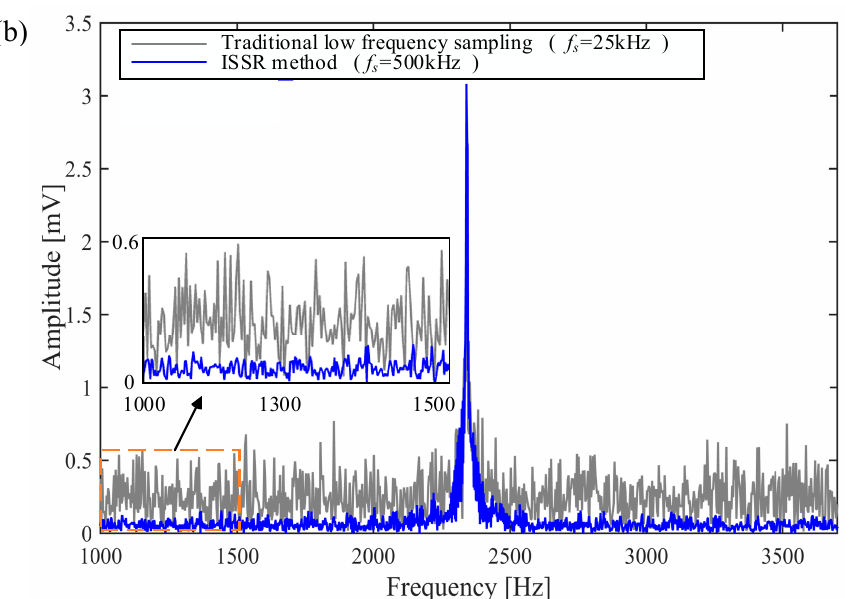
Figure 14. Comparison of traditional low frequency sampling and the ISSR method. The gray lines display traditional low frequency sampling recording. The blue lines display the data processed by the ISSR method. ( a ) Comparison in time domain. ( b ) Comparison in frequency domain.